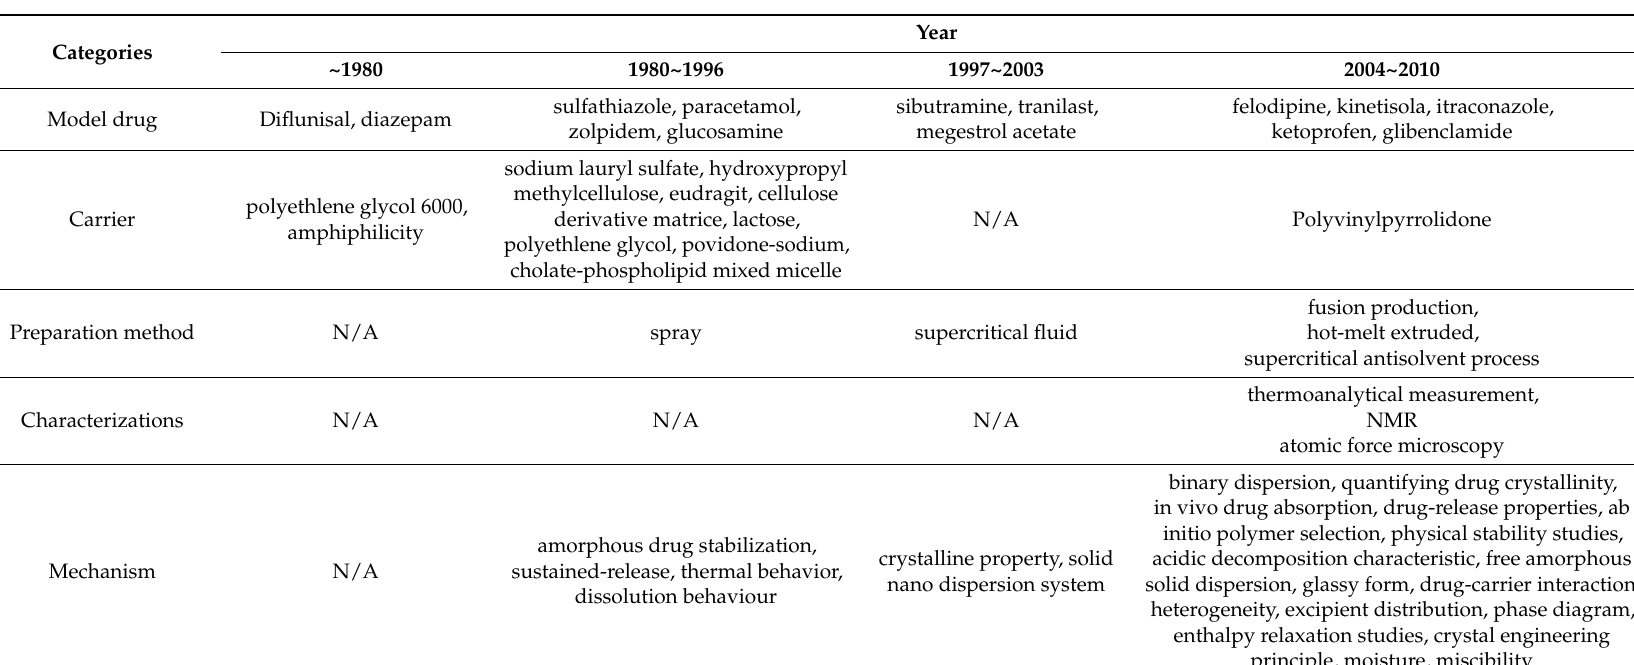
Table 6. Terms of active research clusters with time from co-citation